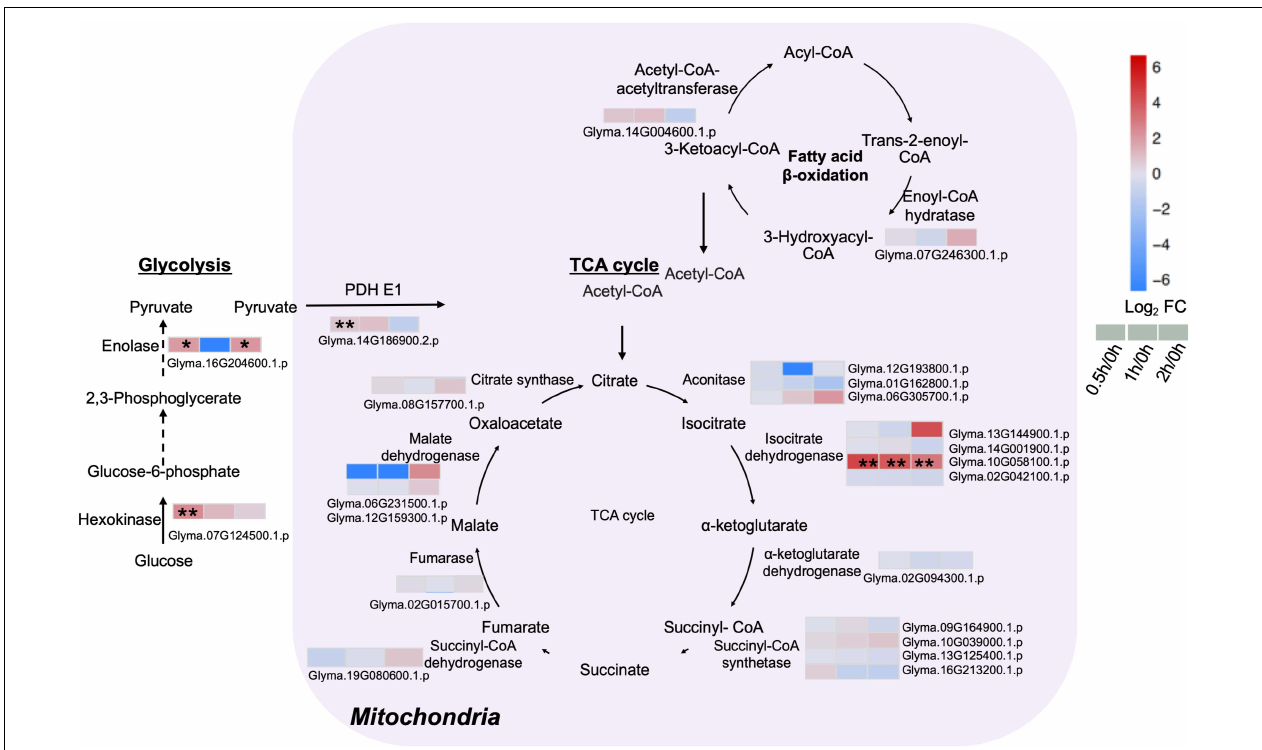
FIGURE 5 | Proteins with differential abundance involved in the tricarboxylic acid (TCA) cycle, glycolysis and fatty acid β -oxidation pathway during salt stress in leaves of soybean ( Glycine max [L.] Merr.) accession C08. Each significant differentially expressed protein is presented as heatmaps with shades of red or blue according to the scale bar. Scale bar indicates log 2 -fold changes of protein abundance (stress vs. control) with an adjusted p -value ≤ 0.05. *, significant difference at p ≤ 0.05; **, significant difference at p ≤ 0.01 using ANOVA test. Black arrow, reaction between two intermediates; dashed arrow, several steps in the reaction. For tandem mass spectrometry, the total leaf protein was extracted from leaves of 14-day-old C08 seedlings grown in 1/2 strength Hoagland solution and treated with or without 0.9% (w/v) NaCl. Differential protein abundances were calculated by label-free quantification of MS peptide signals. PDH E1, pyruvate dehydrogenase E1